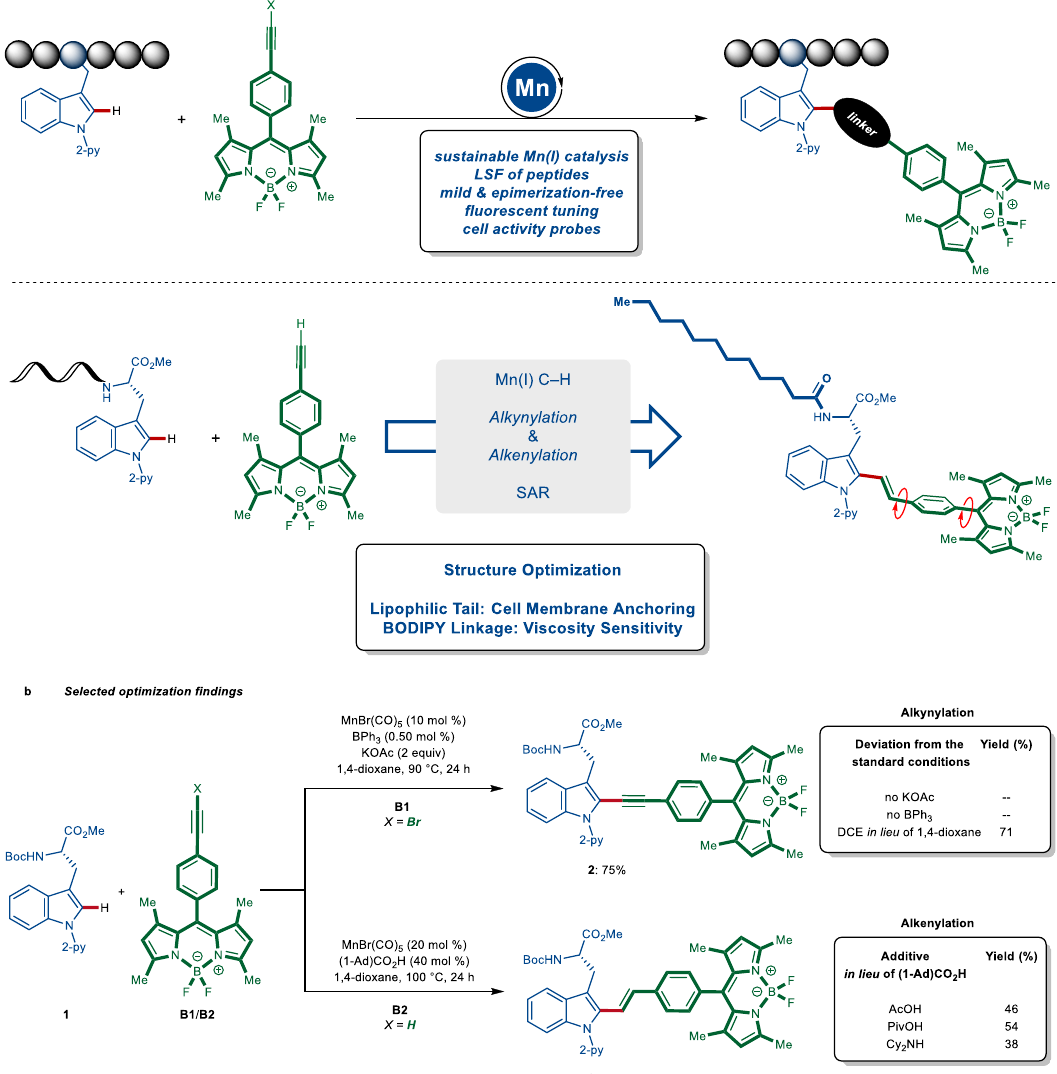
Fig. 1 Divergent and modular assembly of fl uorogenic probes via Earth-abundant manganese(I)-catalyzed C – H activation. a A versatile approach towards diverse fl uorogenic probes. b Selected optimization fi ndings for the utilization of bromoalkyne B1 and terminal alkyne B2 to furnish linear alkynylated and bent alkenylated BODIPY amino acid imaging probes. 2-py, 2-pyridyl; SAR, structure – activity relationship; (1-Ad)CO 2 H, 1- adamantanecarboxylic acid; DCE, 1,2-dichloroethane; PivOH, pivalic